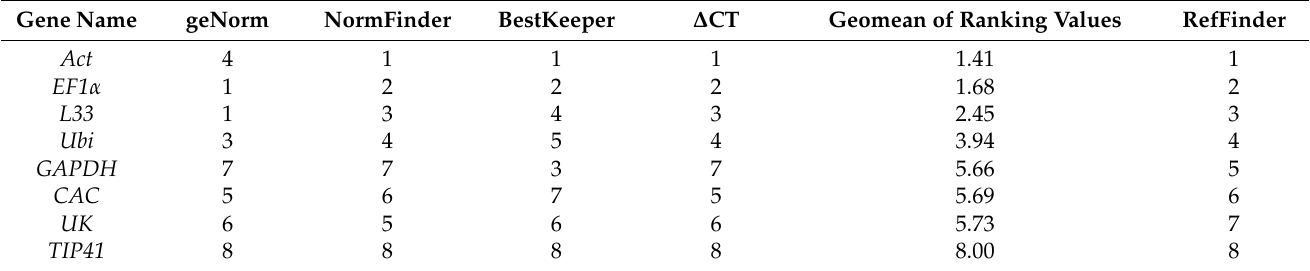
Table 7. Ranking of reference gene stability in the ‘62579 (cid:48)